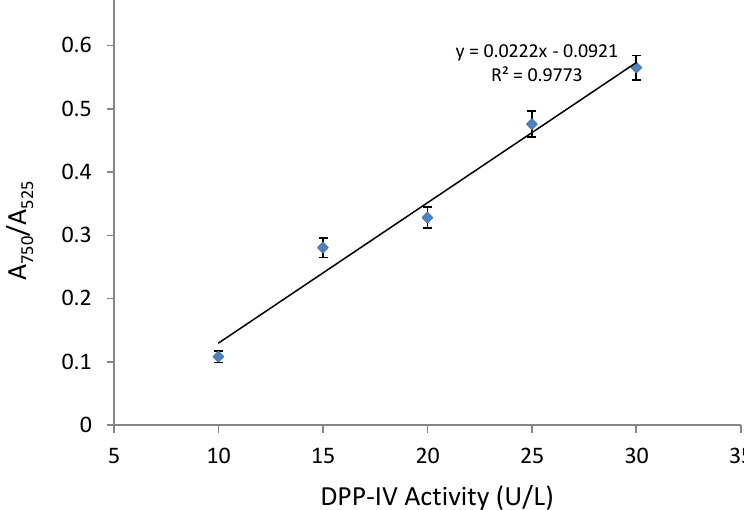
Figure 5. Calibration curve of A 750 /A 525 versus the different activities DPP-IV incubated with C/G-capped Au NPs. Error bars represent the standard deviation (n =